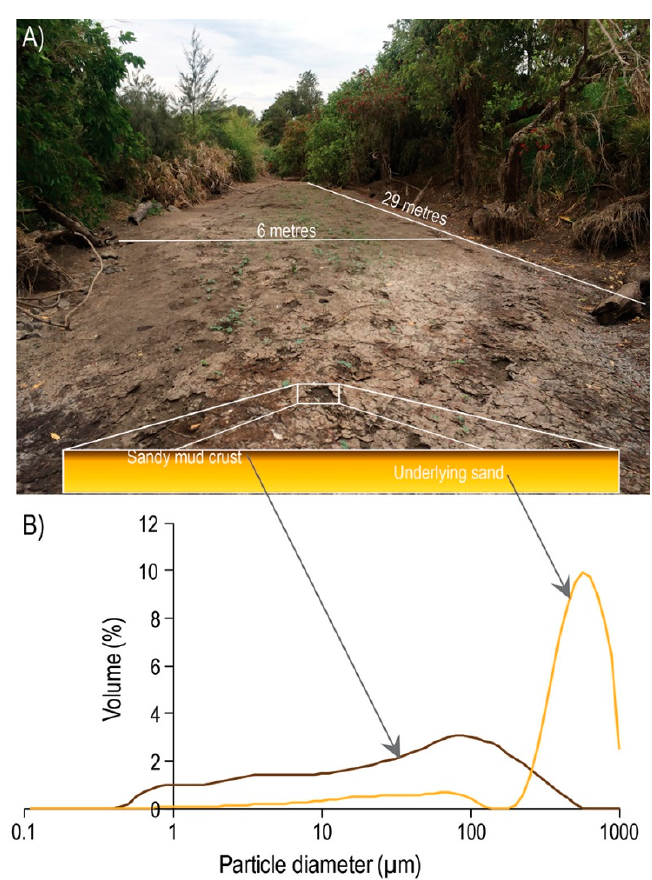
Figure 8. ( A ) Image of creek bed facing upstream of the study site showing muddy crust overlying the large sandy bed deposit. ( B ) Particle size distribution of the muddy crust as well as the underlying sandy bed. Table 1. Total nutrient concentrations from two single stage samplers during the flow event collected at 12:10 p.m. and 7:00 p.m. on 30 March 2017. The washload refers to samples that passed through a 63-